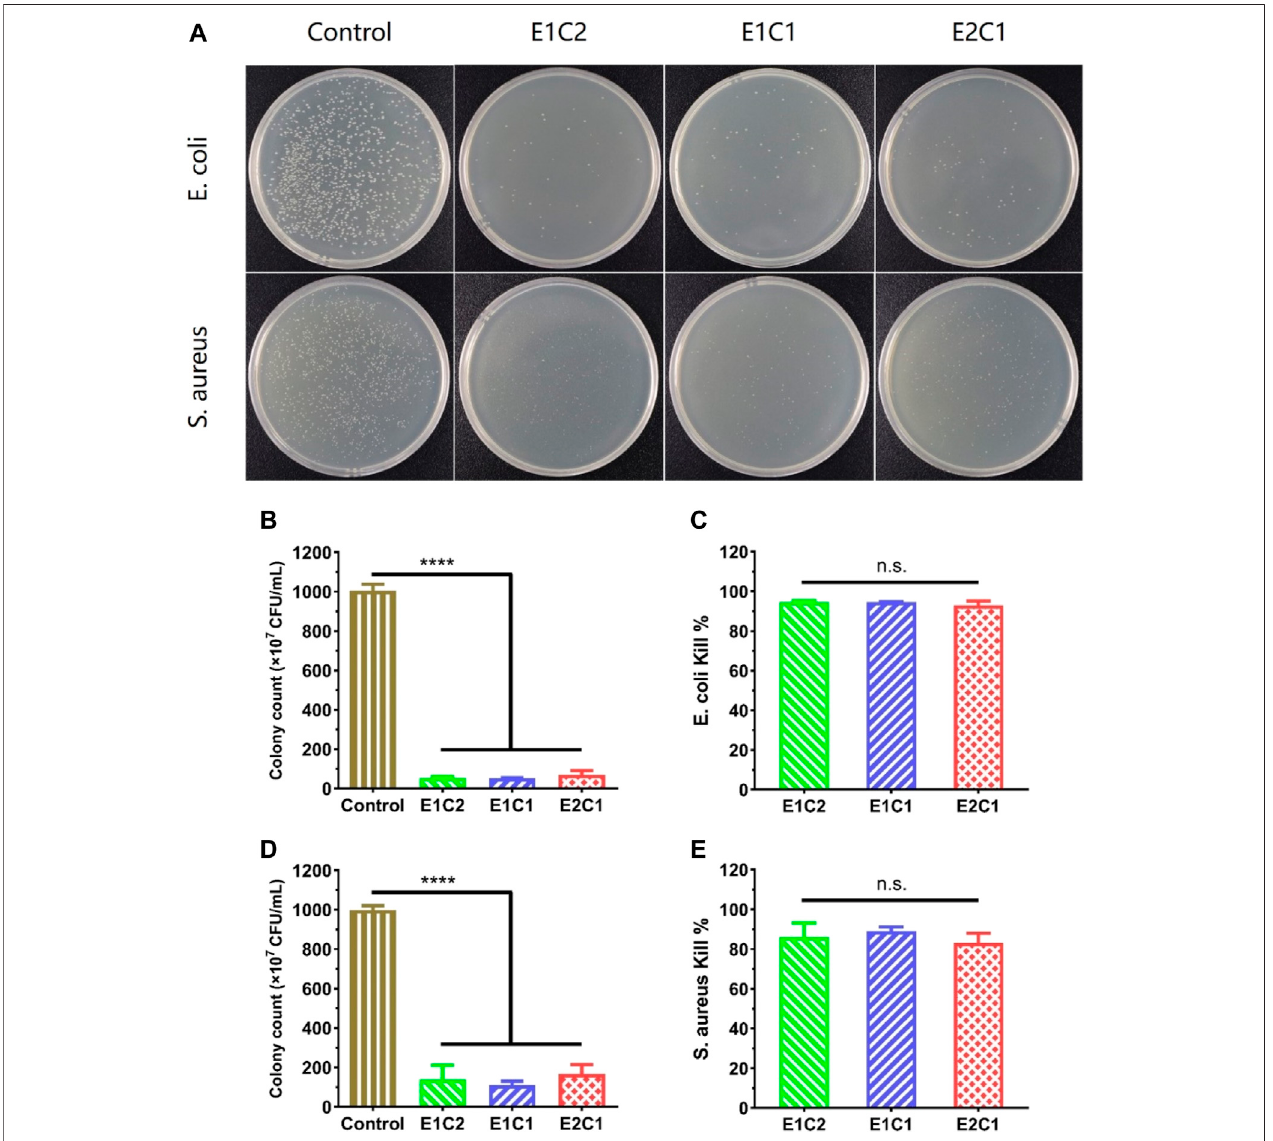
FIGURE8| TheantibacterialactivityoftheNDM-CSscaffolds. (A) Imagesofcoloniesof E.coli and S.aureus derivedfromthescaffolds. (B) Thecoloniesof E.coli in differentgroups. (C) E.coli inhibitionrateofNDM-CSscaffolds. (D )Thecoloniesof S.aureus indifferentgroups. (E) S.aureus inhibitionrateofNDM-CSscaffolds.**** p < 0.0001. n.s.: p >